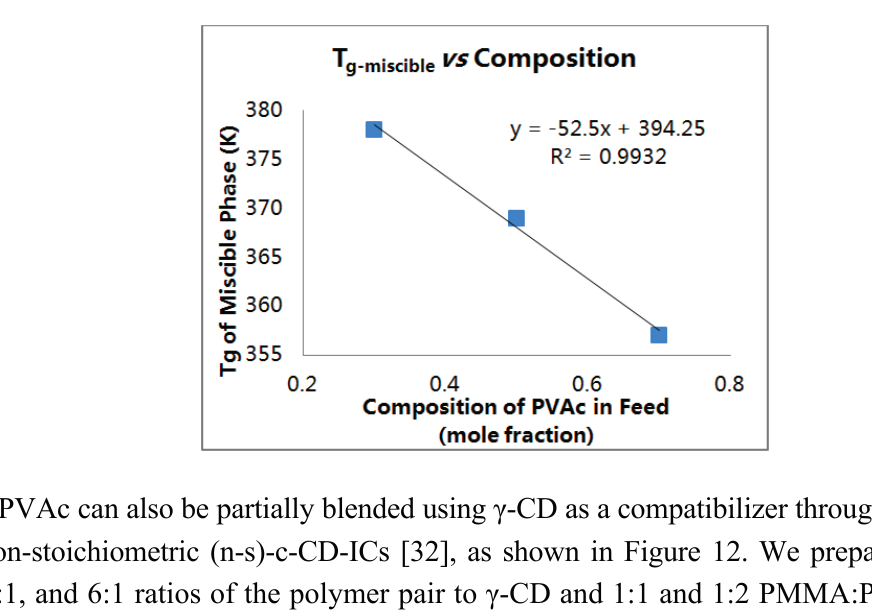
Figure 11. T s observed ( ■ ) for PMMA/PVAc blends coalesced from their g-miscible